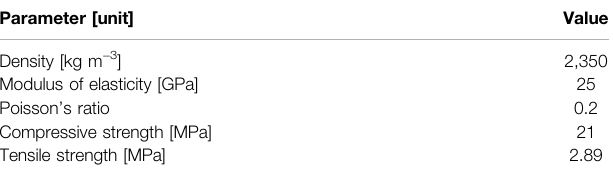
TABLE 2 | Summary of parameters and values used in COMSOL Multiphysics.